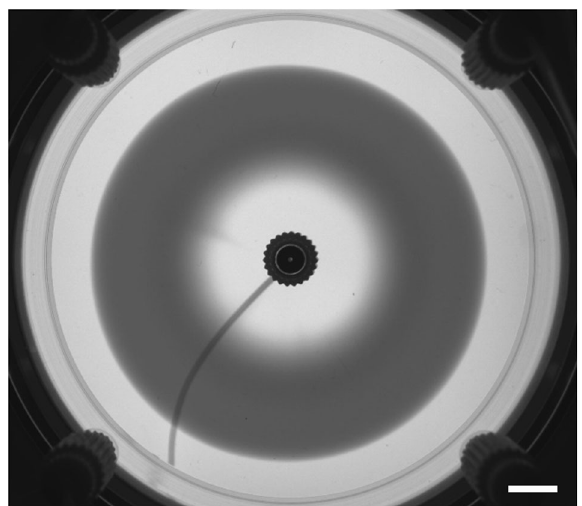
Fig. 6 Reaction-diffusion-advection front in a chemical system. Radial reaction-diffusion-advection front generated by a simple bimolecular reaction A + B → C when a reactant A is injected at a constant fl ow rate in a quasi-2D reactor pre fi lled with the reactant B. In the absence of buoyancy-driven currents under microgravity, the dark product C spreads as an expanding circle 12 . Scale bar: 10